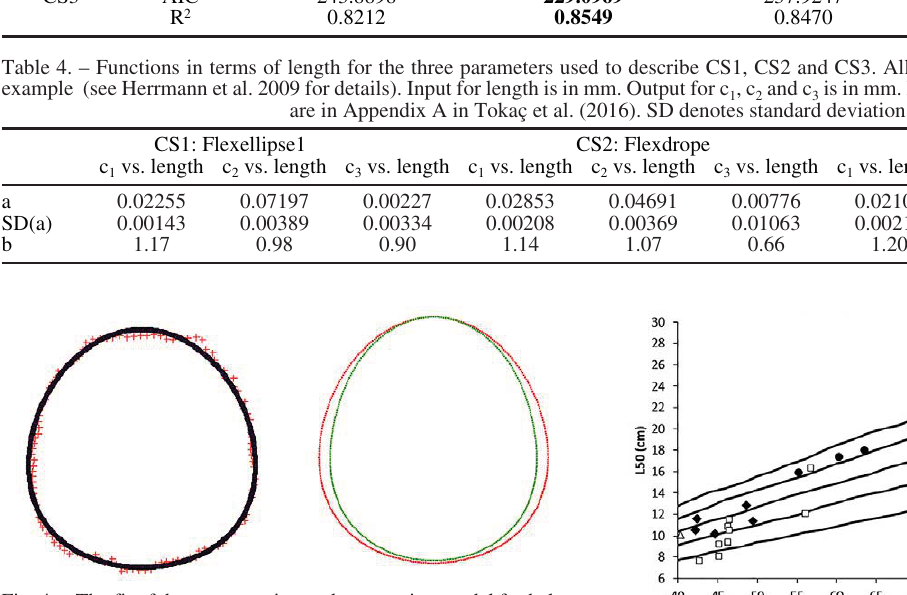
Fig. 4. – The fit of the cross-section and penetration model for hake. Left, example of a fit of the model selected for CS1 (Flexellipse1) to describe the cross-section; right, penetration model of CS1. The Fig. 5. – Predicted L50 values for diamond mesh codends for mesh red (outer) curve represents the uncompressed outline and the green sizes between 40 and 100 mm and opening angle of 20° and 40°, (inner) curve the compressed outline during mesh penetration ac- and linear trend lines and previously published L50 data from field cording to the penetration model. experiments (Table 1). Black diamonds represent Turkish experi- mental results, white squares Italian ones, black circles Portuguese ones, white triangles Spanish ones and the cross the Danish one (see Table 1).